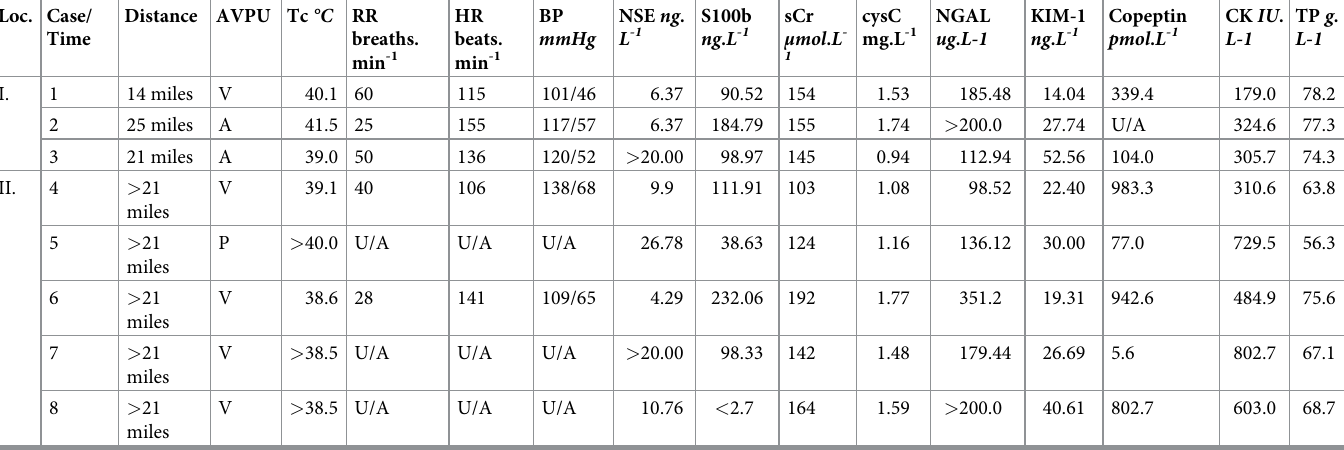
Table 1. Clinical and biochemical results for eight EHI cases sampled within 30 minutes of incapacity (T0 sampling point). Loc. 1. Treatment facility stationed at 14 mile-point on course (NB course design resulted in runners up to 21 miles being received here). Location II. Main medical tent stationed 100 m behind finishing line. Loc. Case/ Distance AVPU Tc °C RR Time